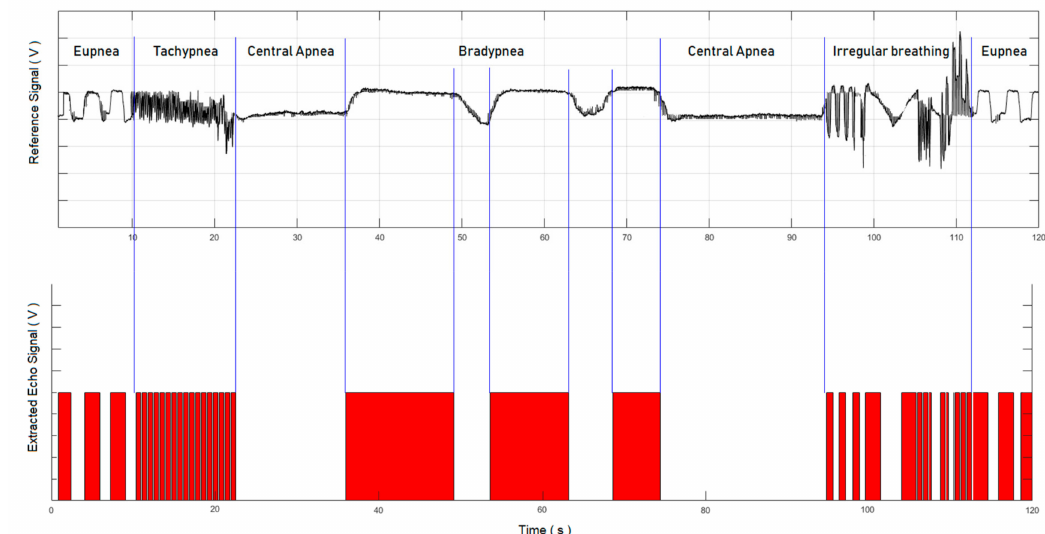
Figure 5. The breathing signal obtained by the reference system (upper trace) and the breathing signal obtained by the proposed monitoring system (lower trace).